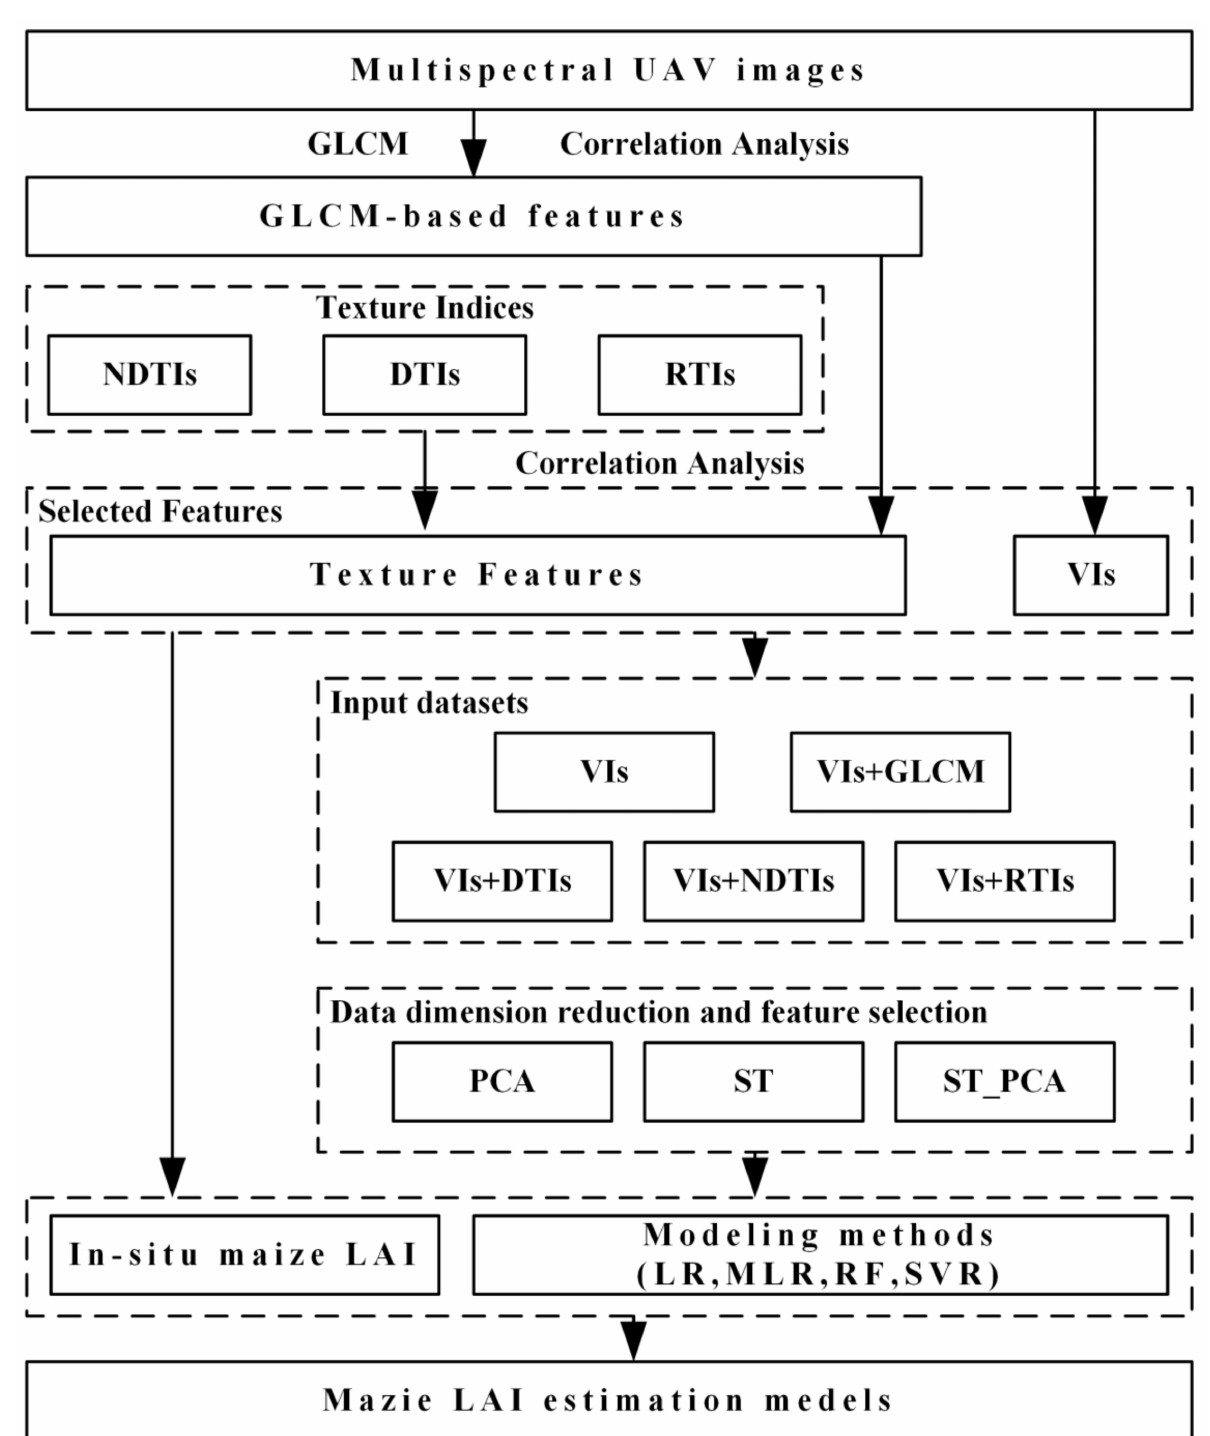
Figure 2. Experimental methodology and procedure of the statistical analysis in this